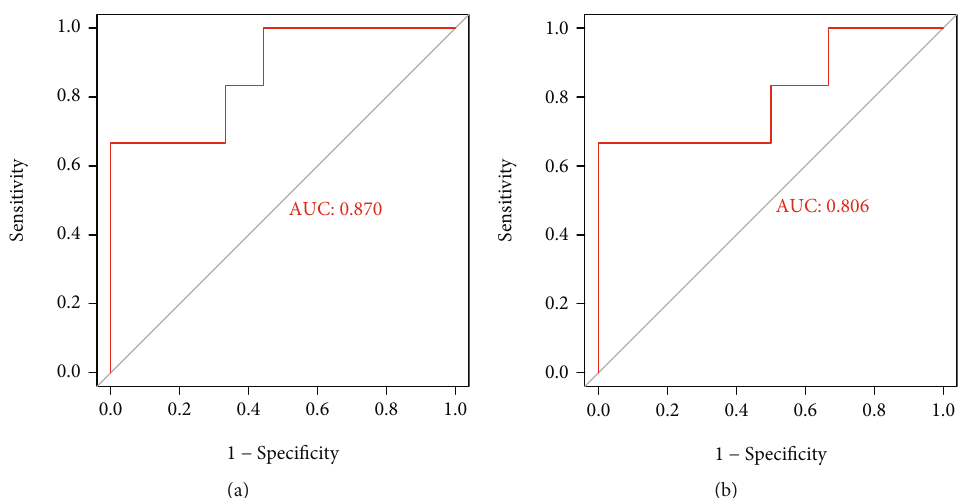
Figure 4: Results of ROC veri fi cation: (a) ROC curve of LANCL1 in veri fi cation data set of GSE70006; (b) ROC curve of LANCL1 in veri fi cation data set of GSE91396.